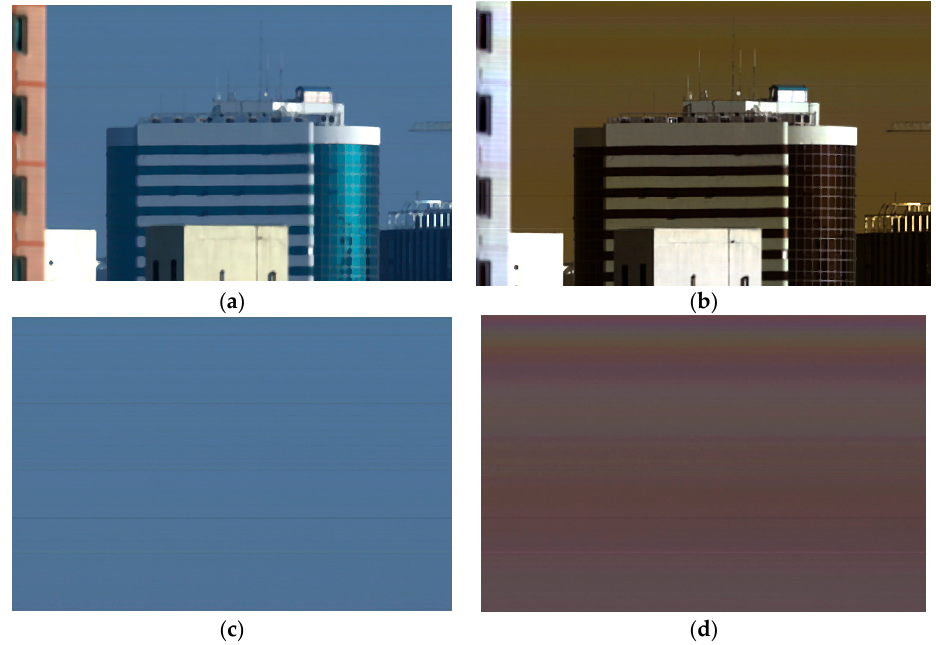
Figure 16. Correction results of the ground data using the flat-field method. ( a ) A sub-image of “buildings” in visible bands (R: 650 nm, G: 560 nm, B: 480 nm); ( b ) A sub-image of “buildings” in NIR bands (R: 740 nm, G: 825 nm, B: 955 nm); ( c ) A sub-image of “the sky” in visible bands (R: 650 nm, G: 560 nm, B: 480 nm); ( d ) A sub-image of “the sky” in NIR bands (R: 825 nm, G: 912 nm, B: 976 nm). Remote Sens. 2018 , 10 , 79